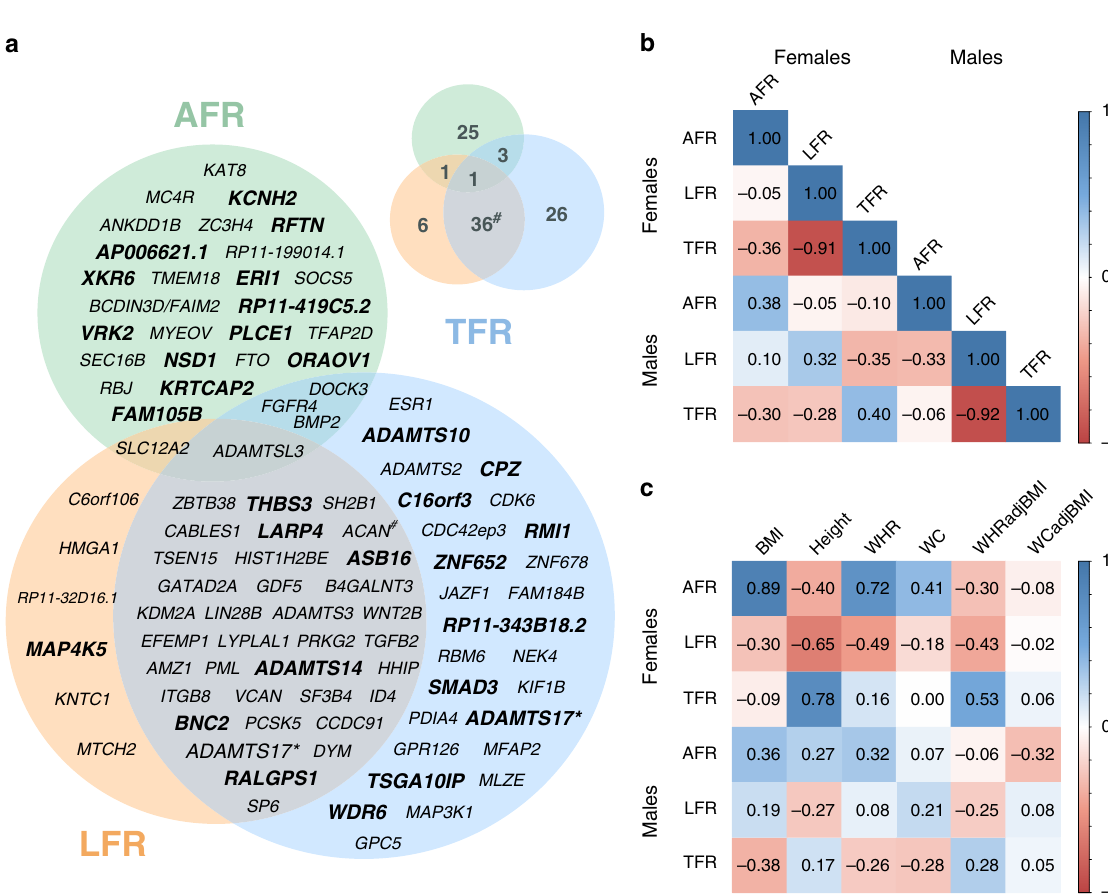
Fig. 2 Overlap and genetic correlation between body fat ratios and other anthropometric traits. a The overlap between AFR-, LFR-, and TFR-associated loci is illustrated as a Venn diagram. The loci are denoted by the nearest gene or by the most likely target gene (see methods section). The loci in bold type and larger font designate loci that have not previously been associated with an anthropometric trait. The total number in each fi eld is illustrated top right. *: Two independent signals were observed within the ADAMTS17 locus: one with an effect on LFR and one on TFR. #: Two independent associations with LFR and TFR were observed within the ACAN locus. b Genetic correlation between body fat ratios within, and between sexes. Genetic correlations were estimated by cross-trait LD-score regression 32 . The absolute values for each genetic correlation ( r g ) is included. c Genetic correlations between body fat ratios and standard anthropometric traits. Sex-strati fi ed summary statistics were generated for each trait by GWAS in the discovery cohort. Color scales represent genetic correlation and range from red ( − 1.0: perfect anticorrelation) to blue (1.0 perfect